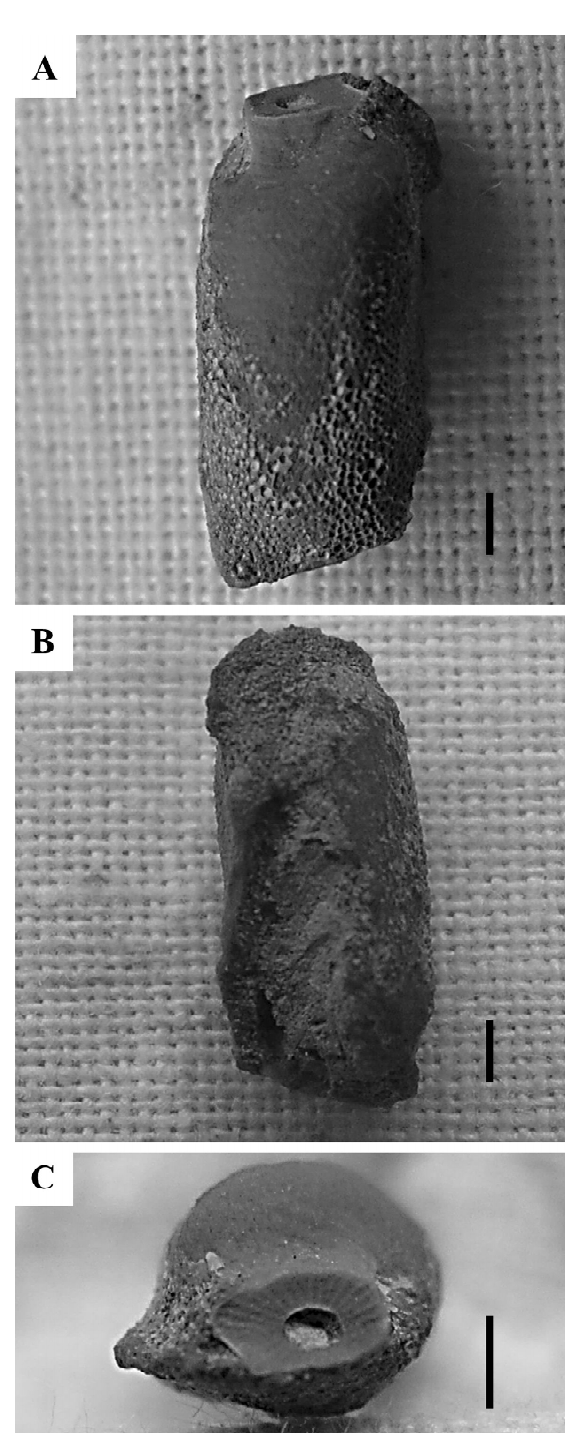
Fig. 4. Swollen crinoid pluricolumnal (CMC IP 71254) from the study site. A , lateral view of the specimen, showing amorphous swelling and an encrusting bryozoan; B , lateral view of the other side of the specimen, showing post-mortem damage; C , articular view of the specimen showing crenulae and small, round lumen. All scale bars = 1